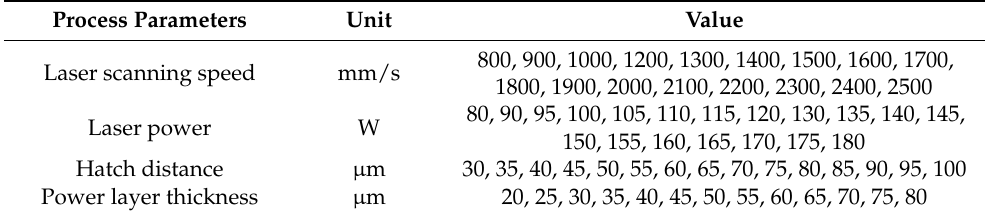
Table 2. SLM process parameters and their ranges used to generate